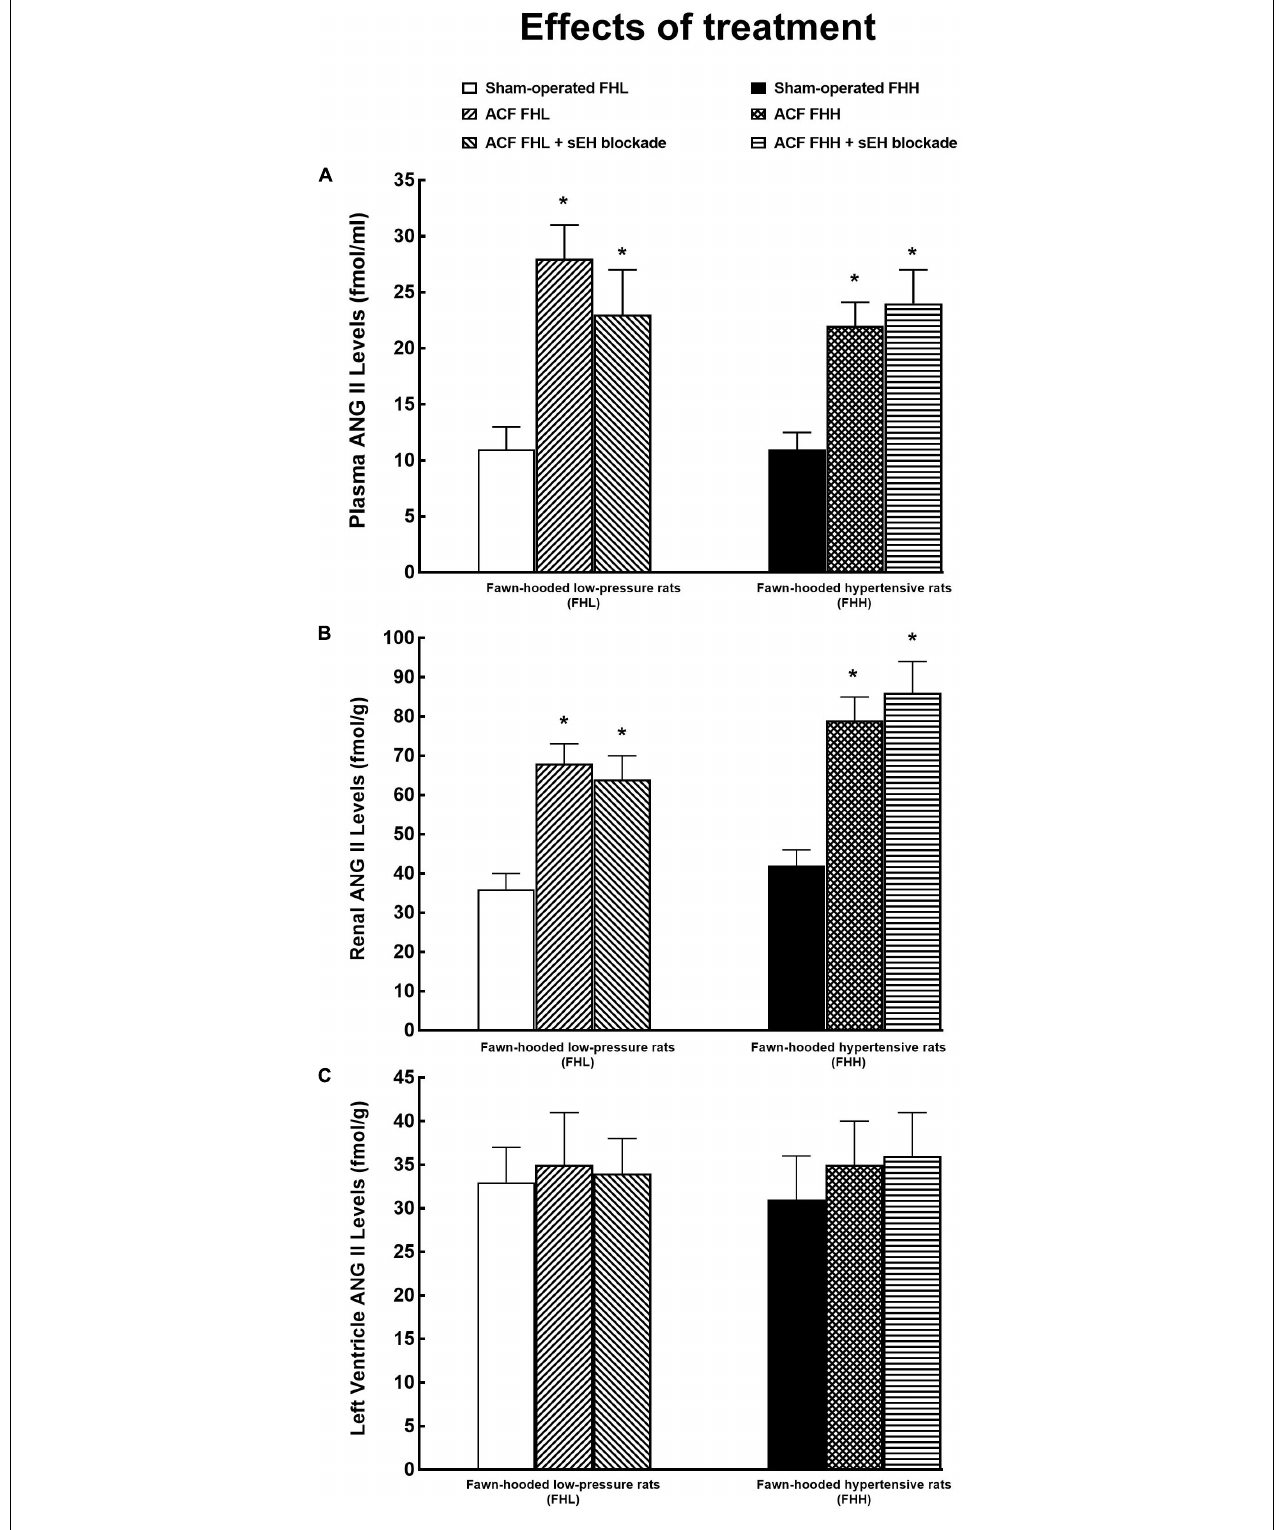
FIGURE 6 | Plasma (A) , kidney (B) , and left ventricle (C) angiotensin II (ANG II) levels in sham-operated fawn-hooded low-pressure rats (FHL) with ACF and ACF FHL rats treated with a sEH inhibitor, and in sham-operated fawn-hooded hypertensive (FHH) rats, untreated and treated with sEH inhibitor. ∗ P < 0.05 compared with the sham-operated counterparts at the same time